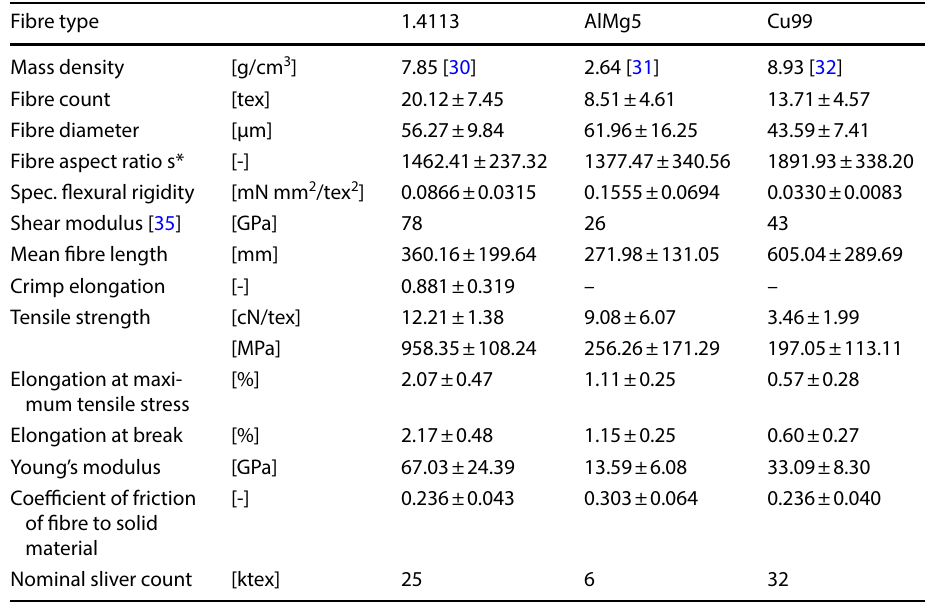
Table 3 Properties of basic material